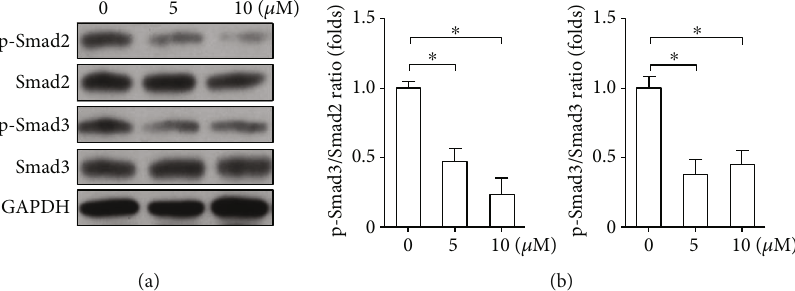
Figure 5: LY2109761 inhibits the Smad2/Smad3 signaling pathway. Keloid-derived fi broblasts were treated with increasing doses of LY2109761. (a) Representative western blots showing protein expression of Smad2 and Smad3 and their respective phosphorylated forms (p-Smad2 and p-Smad3). (b) Relative protein expression levels are shown as the mean ± SEM from three independent experiments. Glyceraldehyde 3-phosphate dehydrogenase (GADPH) was used as an internal control. ∗ P < 0 : 05 between LY2109761 groups and DMSO control; ∗∗ P < 0 : 05 between LY2109761 5 μ M and 10 μ M treatment groups.